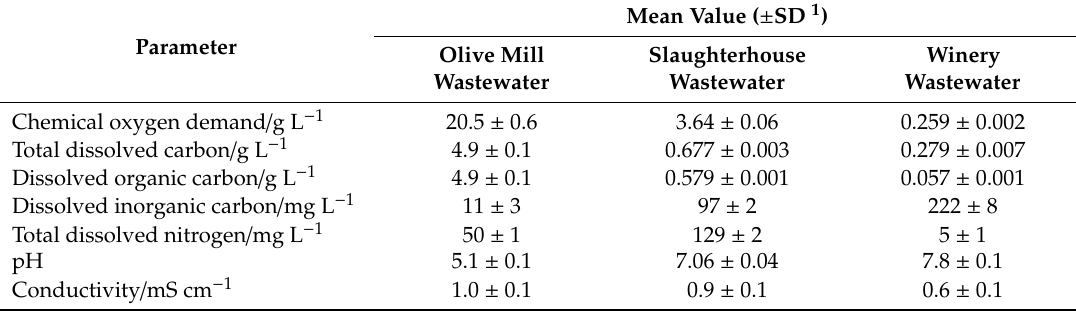
Table 2. Characterization of the samples of olive mill, slaughterhouse and winery wastewaters used in the case-study. Mean Value ( ± SD 1 ) Parameter Olive Mill